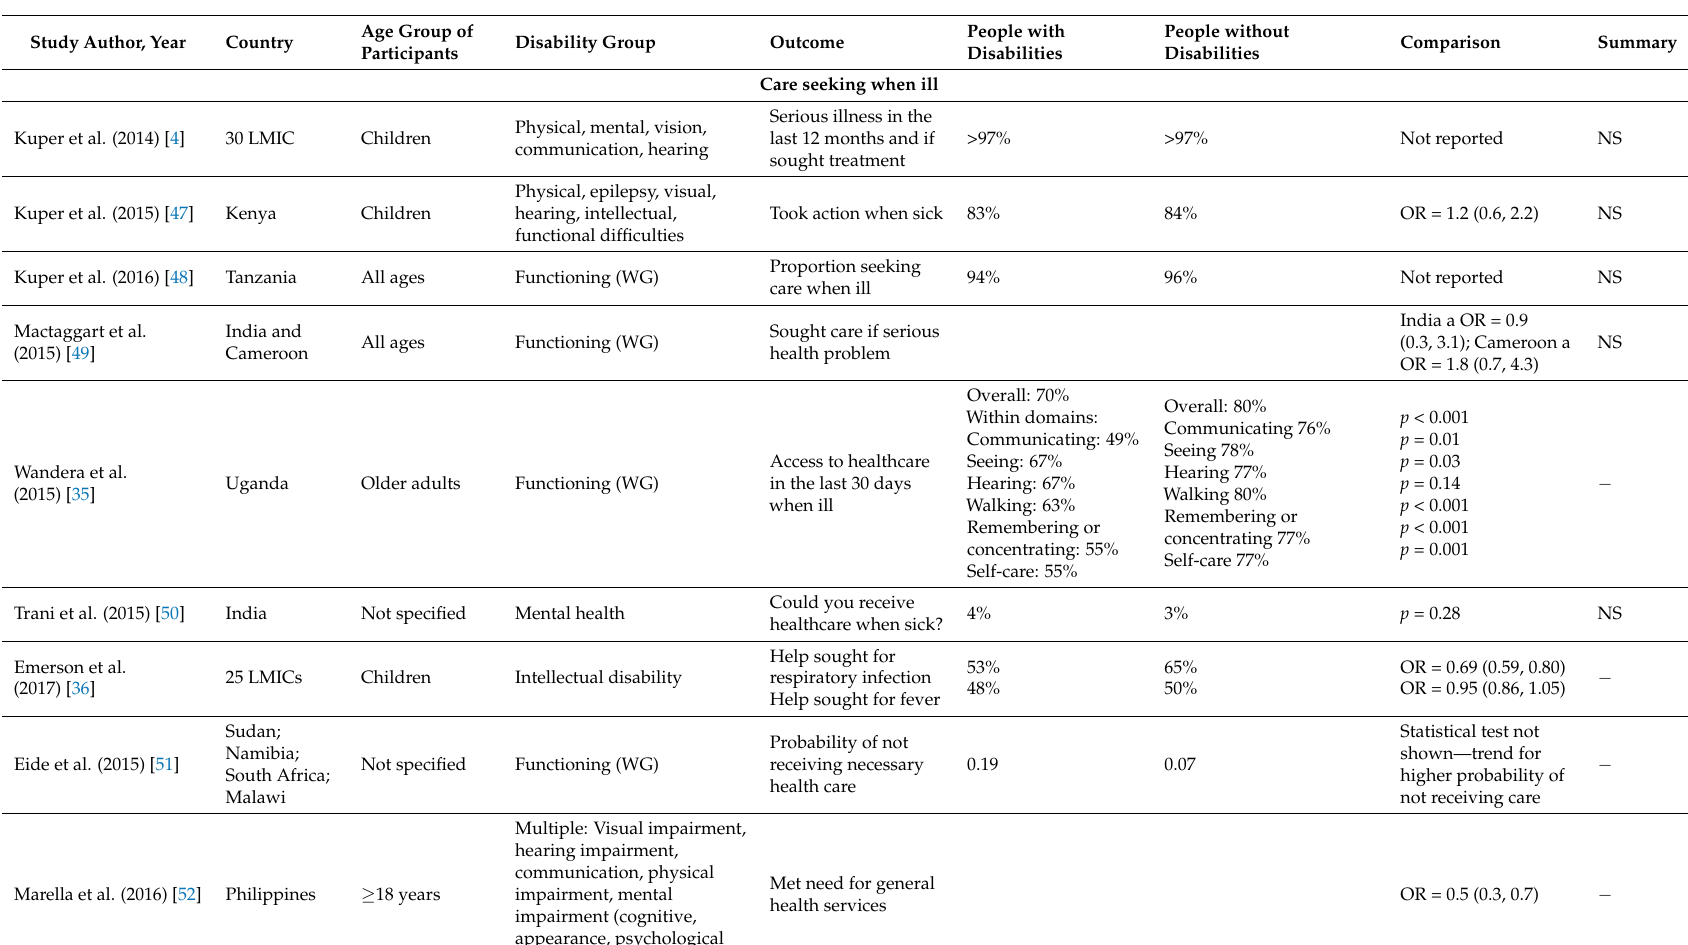
Table 5. Summary of studies measuring